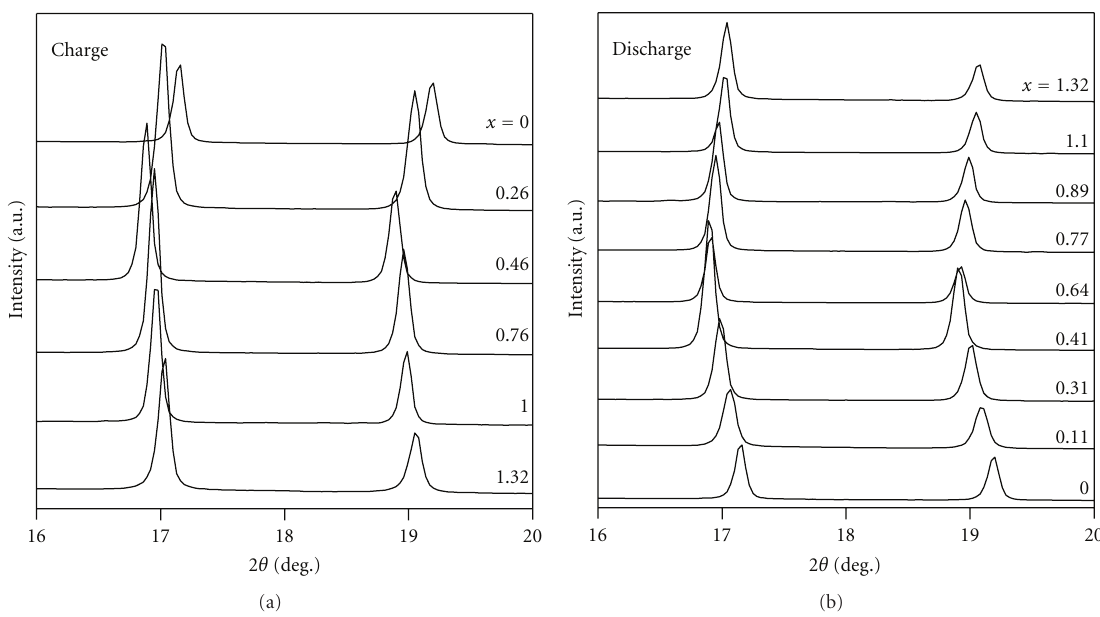
· 3 . 5H ] 2 O. 6 0 . 83